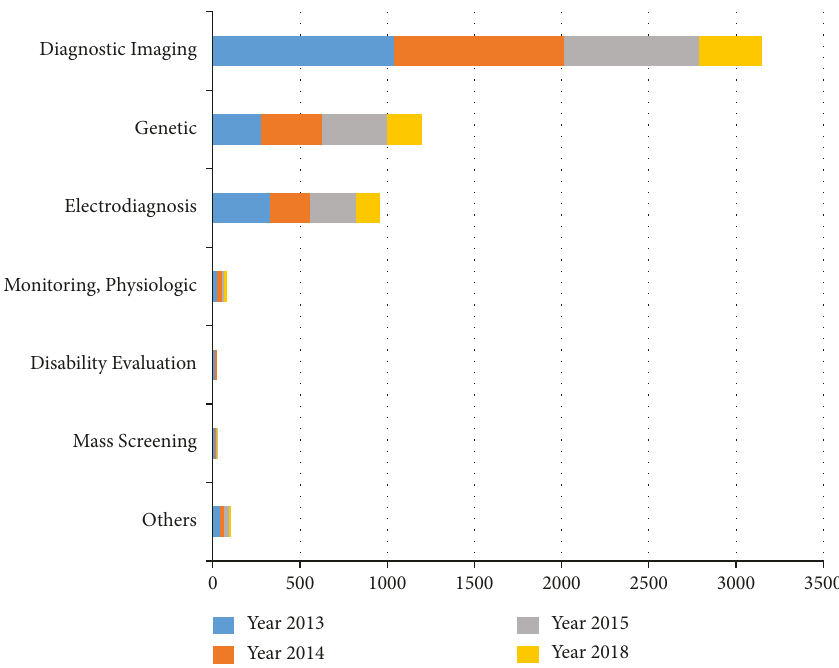
Figure 2: Role of AI in medical imaging